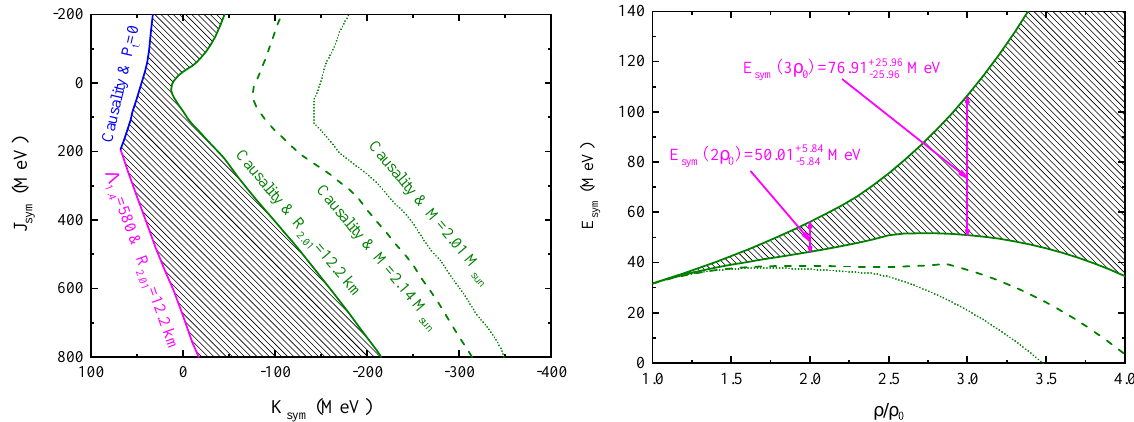
Figure 6. ( Left ) Projections of the indicated crosslines of constant surfaces of NS observables to the K sym − J sym plane for L = 58.7 MeV. ( Right ) The constraints on symmetry energy extracted from the combinations of K sym − J sym in the left plot. E sym ( 2 ρ 0 ) and E sym ( 3 ρ 0 ) are also extracted and